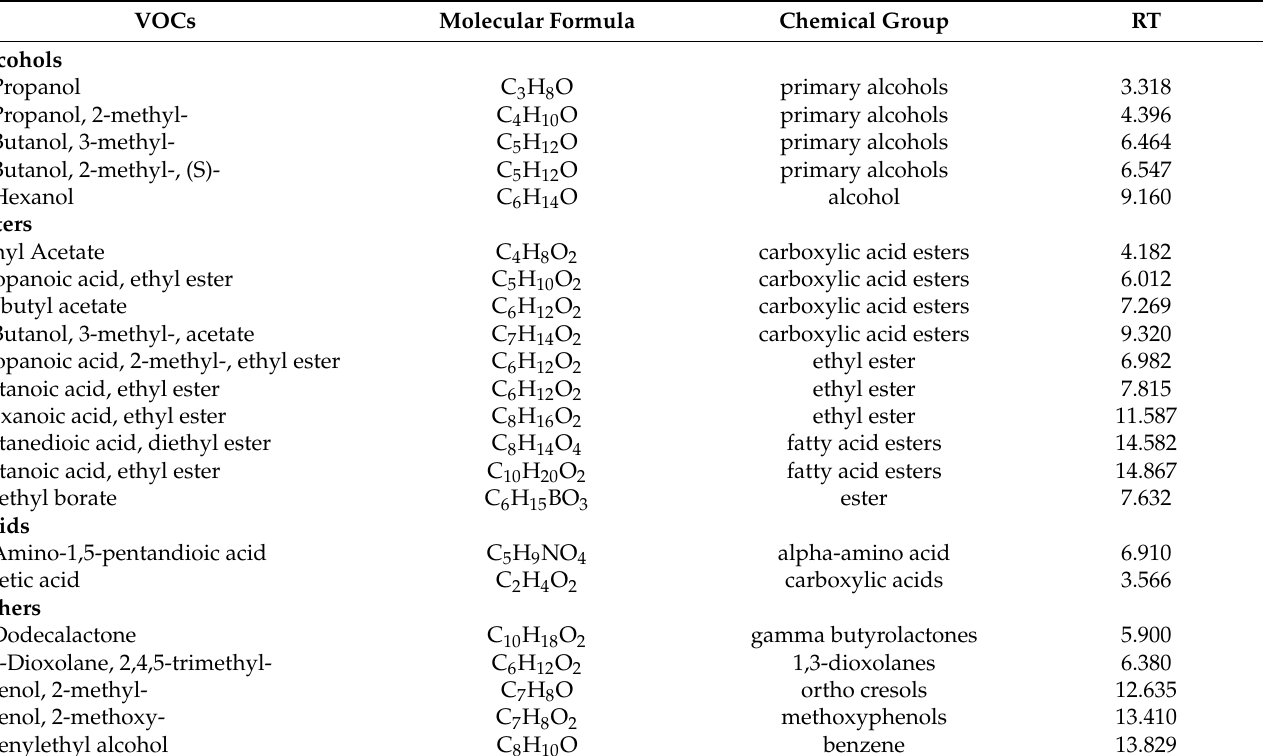
Table 2. Molecular formula, chemical group and retention time (RT) for twenty-two volatile organic compounds (VOCs) determined by gas chromatography from the white wine samples in twenty-one bentonite product treatments including three control treatments (Debrecen-Pallag, Hungary). Molecular